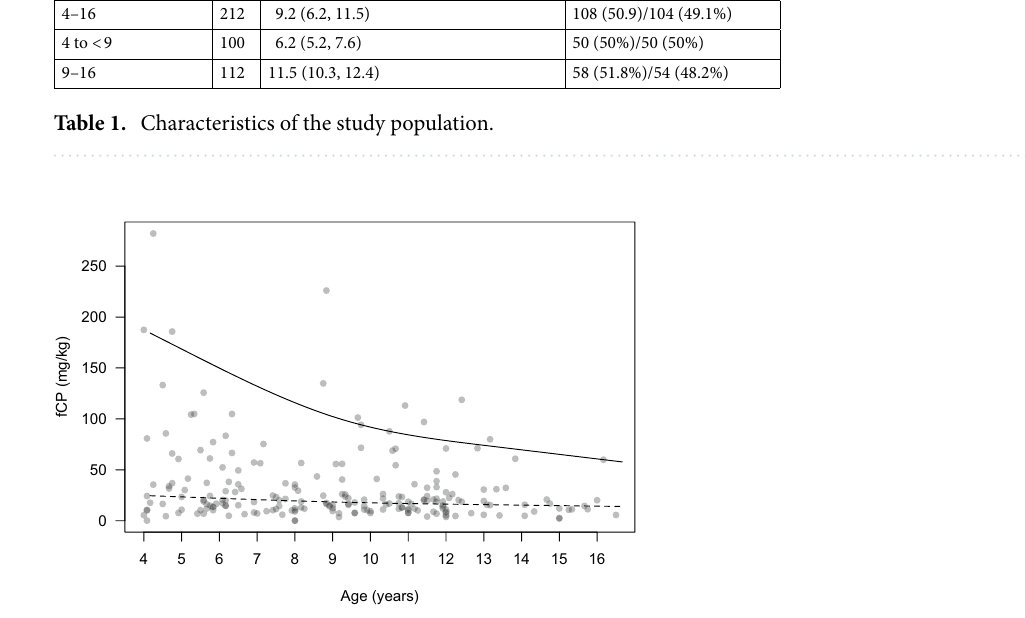
Figure 2. Scatter plot depicting the relationship between age in years and fCP concentrations. Regression lines have been added for the 95th percentile (solid line) and for the 50th percentile (dashed line). ( fCP fecal